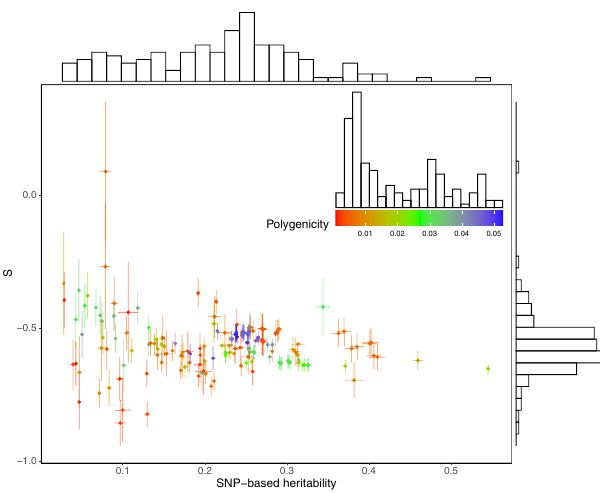
Fig. 3 Estimation of the genetic architecture parameters for 155 complex traits. Shown are the results from the SBayesS analyses using summary data for 130 traits from the Neale Lab and 25 traits from our GWAS analyses and other published studies. The estimated S is plotted against the estimated SNP-based heritability with the histograms showing the marginal distributions of the estimates. Data are presented as posterior means ± posterior standard errors. Colour indicates the estimate of polygenicity for each trait where the scale and distribution are shown in the inset